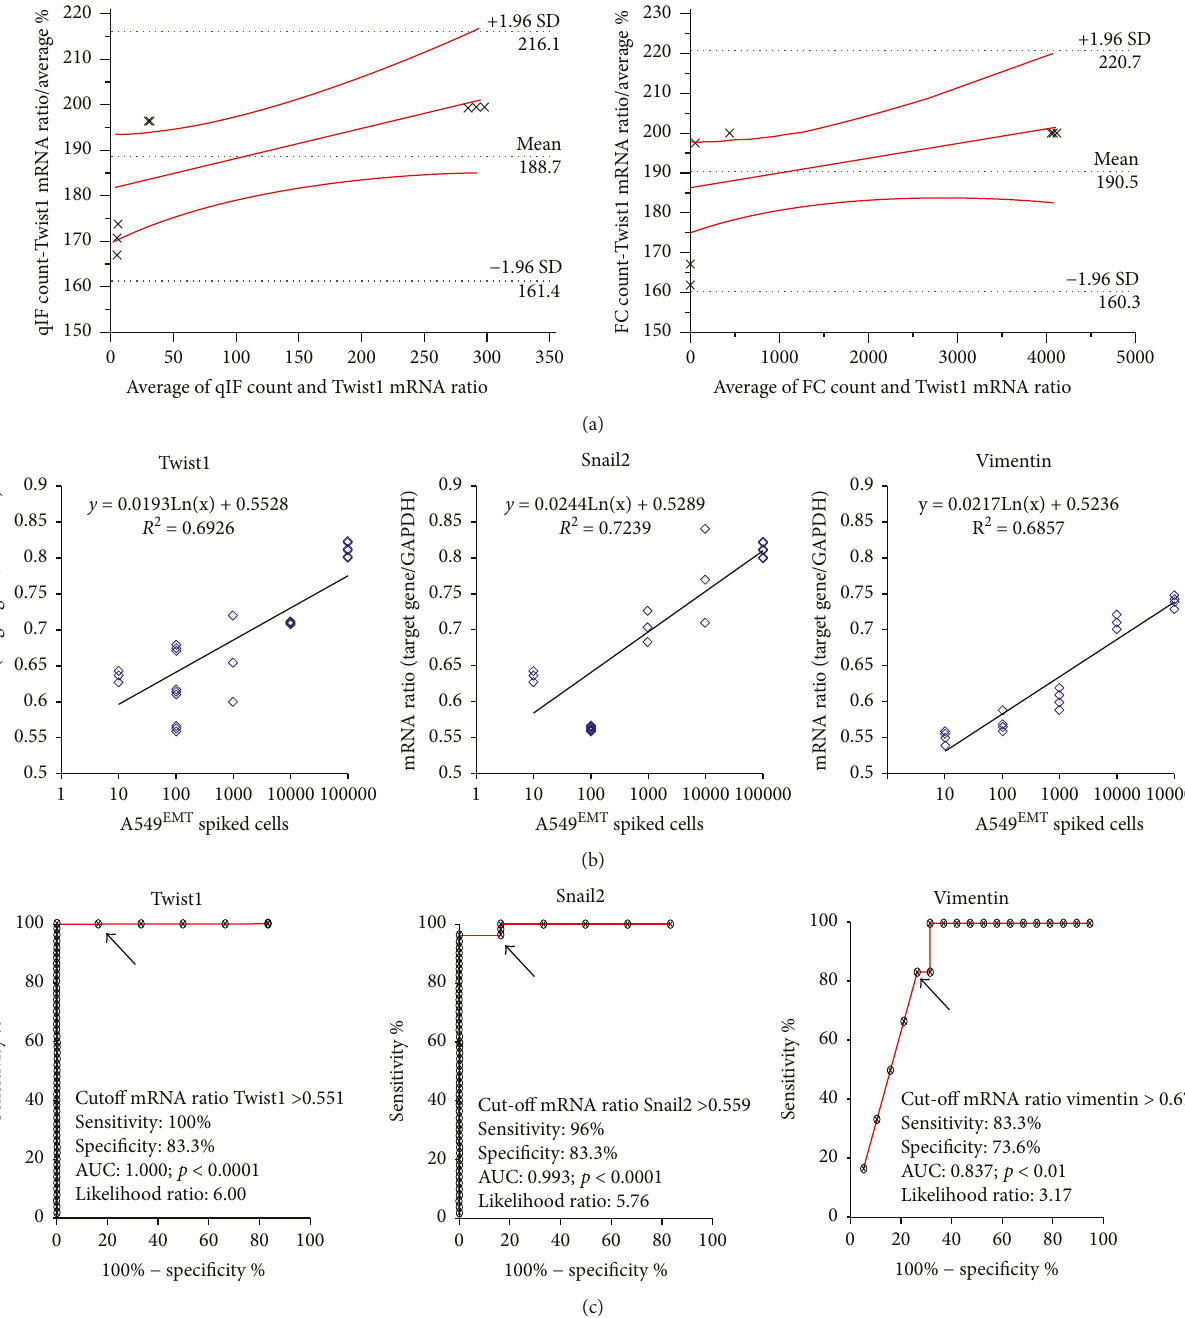
Figure 4: Reliability assessment of the RT-PCR assay. (a) Comparison between RT-PCR assay and control methods for cell counts. The reliability of RT-PCR method was assessed by Bland & Altman plot. At the di ff erent experimental points, the di ff erences between methods were within mean ± 1.96 SD; therefore, the RT-PCR assay was interchangeable with both the qIF and CF assays. (b) Evaluation of the linearity of RT-PCR assay. A signi fi cant correlation between the number of spiked A549 EMT cells and levels of mRNA expression was found for all target genes, mainly for the expression of vimentin ( r 2 : 0.68), Snail2 ( r 2 : 0.72), and Twist1 ( r 2 : 0.69). ( r correlation coe ffi